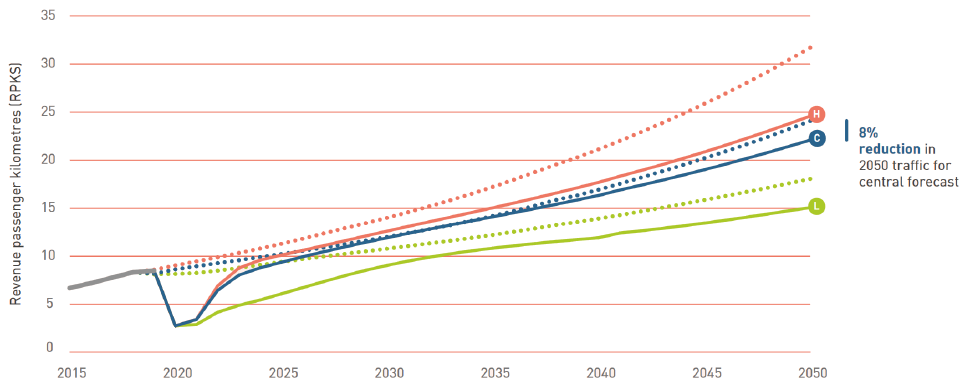
Figure 2. Air Transport Action Group’s pre- (dotted) and post-Covid (solid) predictions for revenue passenger kilometers until 2050, for high (H in red), central (C in blue), and low (L in green) traffic forecasts. Adapted from